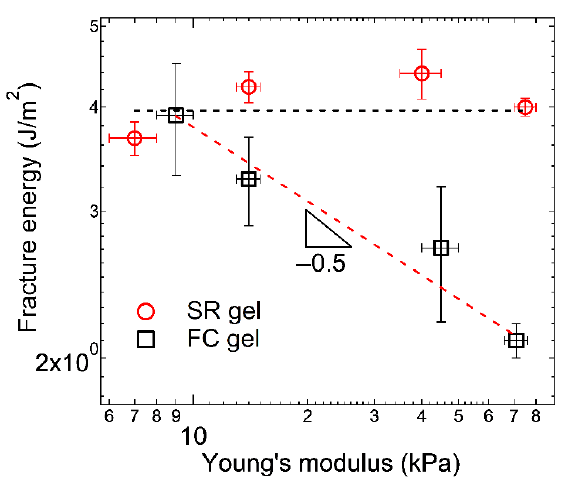
Figure 10. Young’s modulus dependence of fracture energy for FC and SR gels. Reprinted from [23] with permission from American Chemical Society.